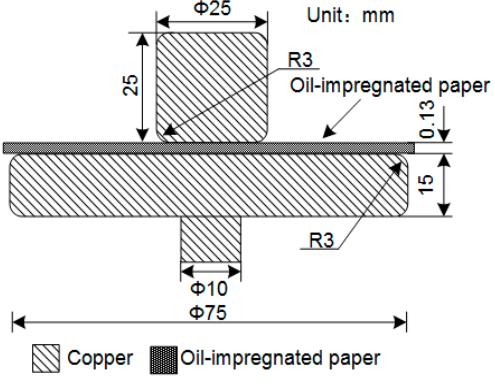
Figure 3. The electrode system.